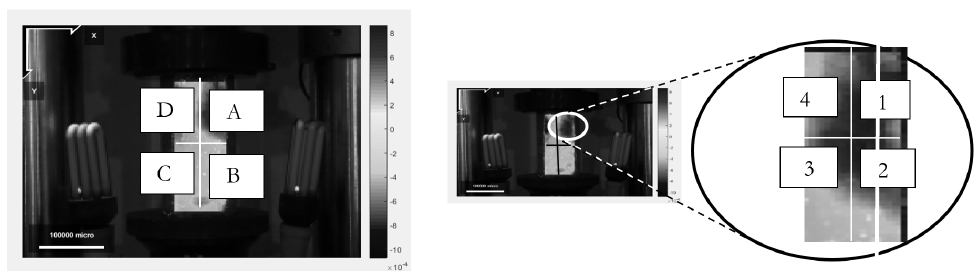
Figure 4 - Indication of quadrants A, B, C, D - Quadrants, 1,2,3,4 - Sub-squares [11]